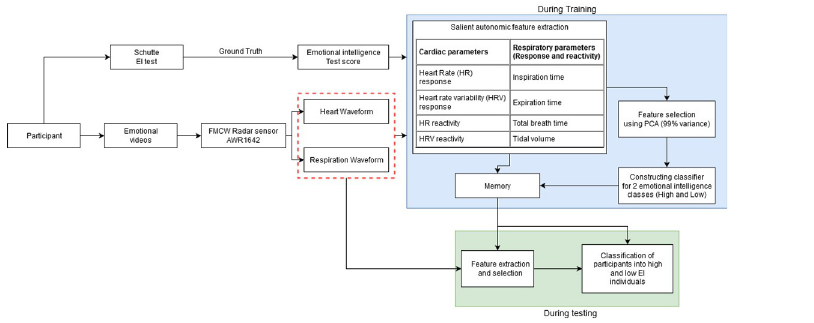
Fig 2. Proposed method for EI prediction.